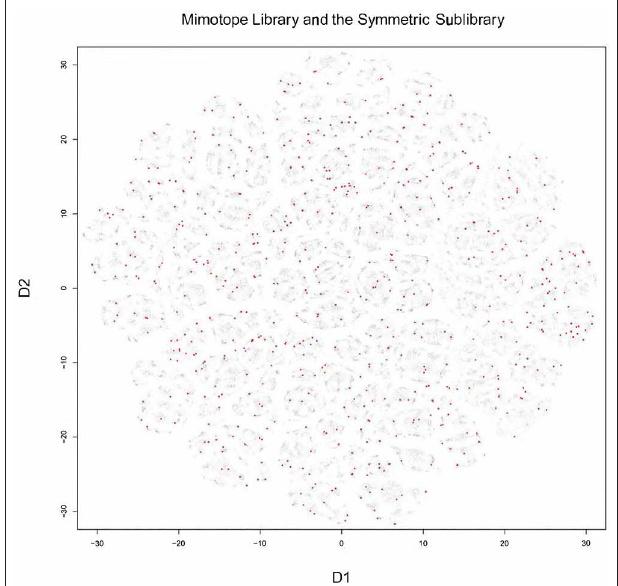
FIGURE 5 | Visualization of the 7-mer mimotope sequence space with the optimized library SYM marked in red. Although individual GibbsCluster defined clusters do not coincide with those shown by t-sne, the mapping of the optimized library apparently probes quite uniformly the mimotope sequence space. t-sne, T-distributed stochastic neighbor